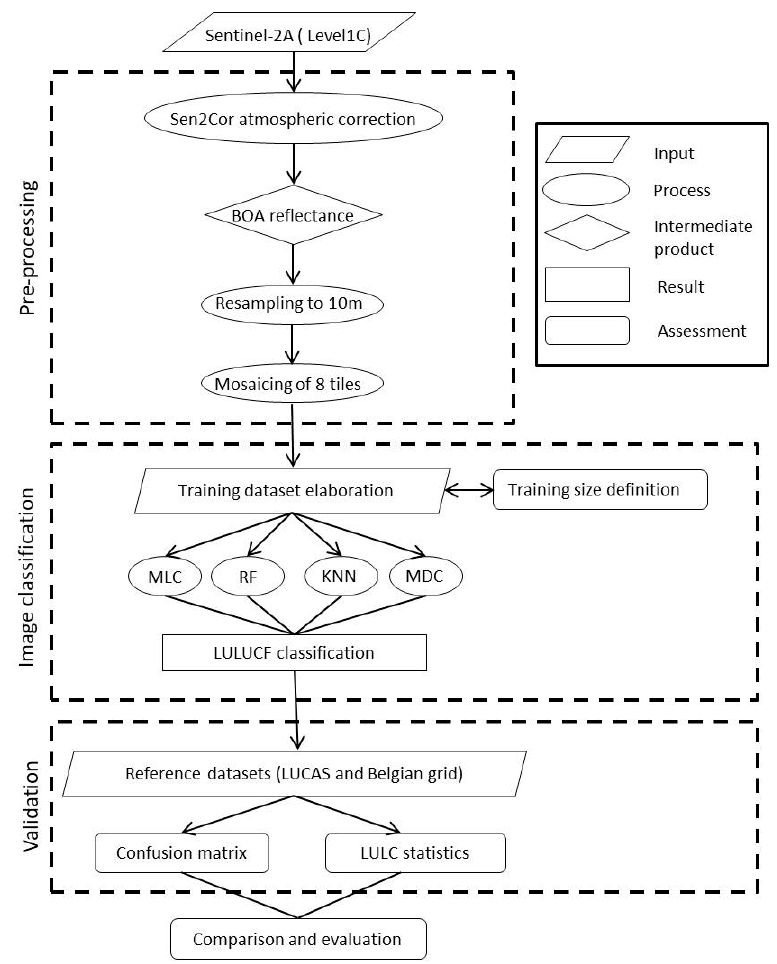
Figure 1. Workflow of the Land Use, Land Use Change, and Forestry (LULUCF) classifications with Sentinel-2 imagery.